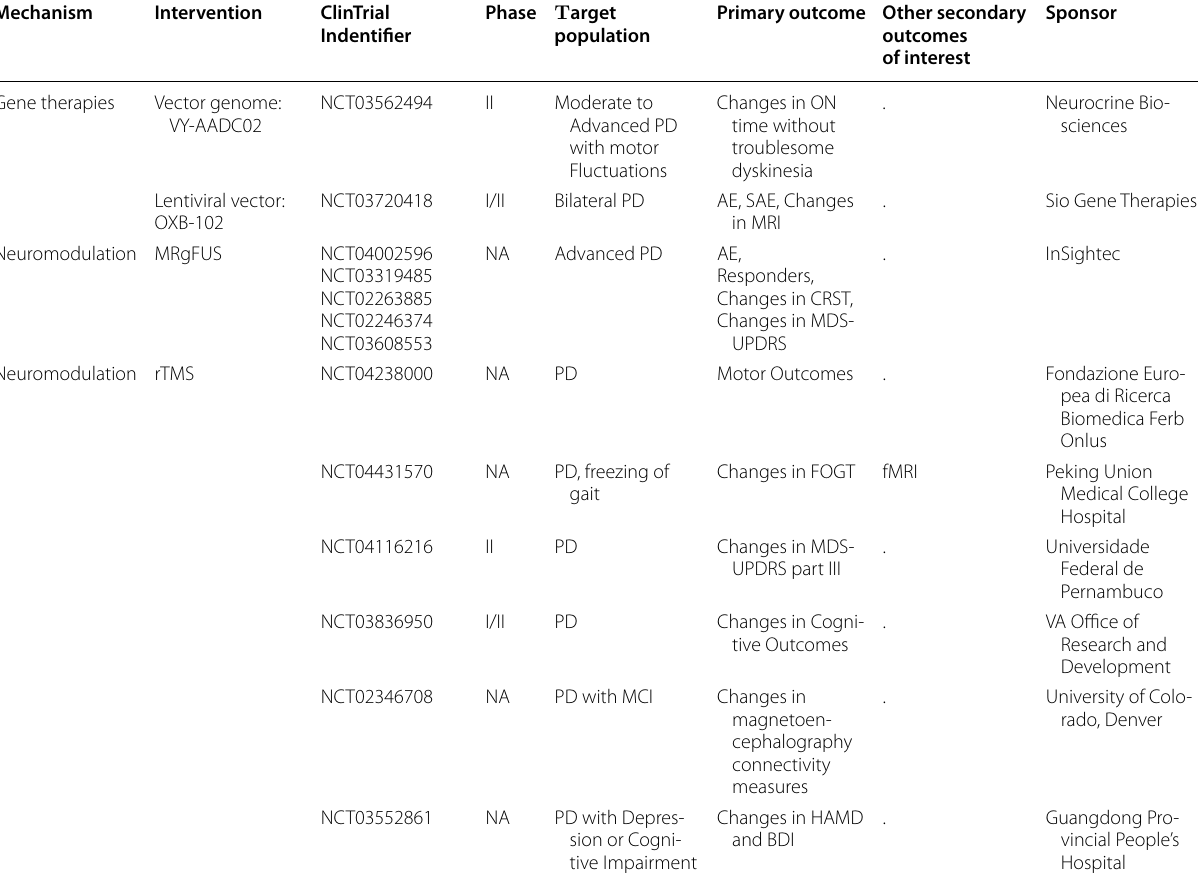
AE Adverse Events, BDI Beck Depression Inventory, CRST Clinical Rating Scale for Tremor, fMRI functional Magnetic Resonance Imaging, FOGT Freezing Of Gait Questionnaire, HAMD Hamilton Depression Scale, MCI Mild Cognitive Impairment, MDS-UPDRS MDS-Unified Parkinson’s Disease Rating Scale, MRgFUS Magnetic Resonance Guided Focused Ultrasound, MRI Magnetic Resonance Imaging, NA Not Applicable; rTMS Repetitive Transcranial Magnetic Stimulation, PD Parkinson’s Disease